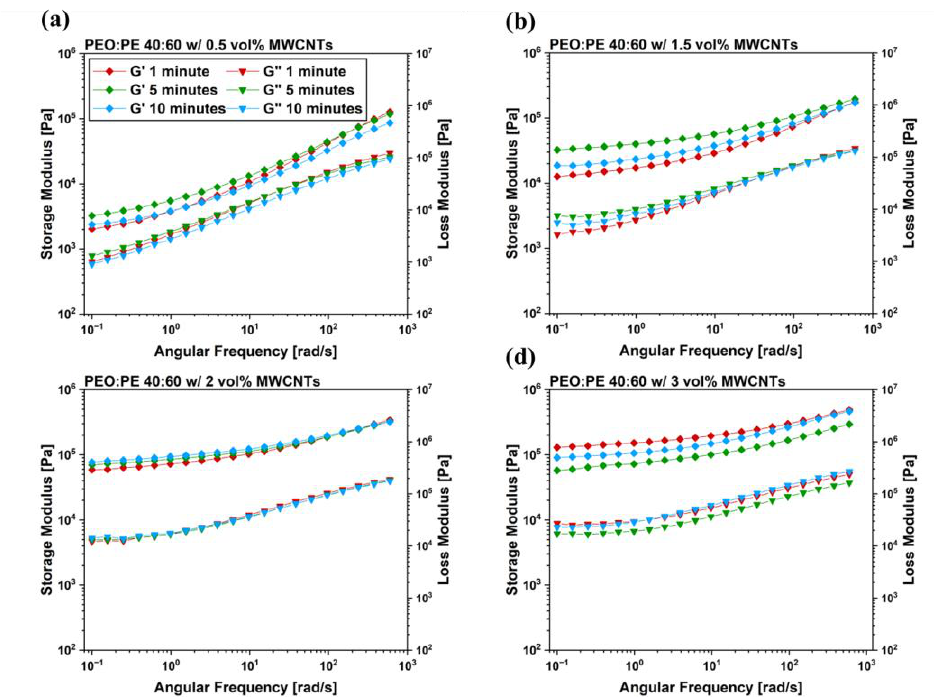
Figure 6. Frequency sweep results for PEO/PE 40:60 blends containing MWCNTs at concentrations of ( a ) 0.5 vol%, ( b ) 1.5 vol%, ( c ) 2 vol%, and ( d ) 3 vol%.